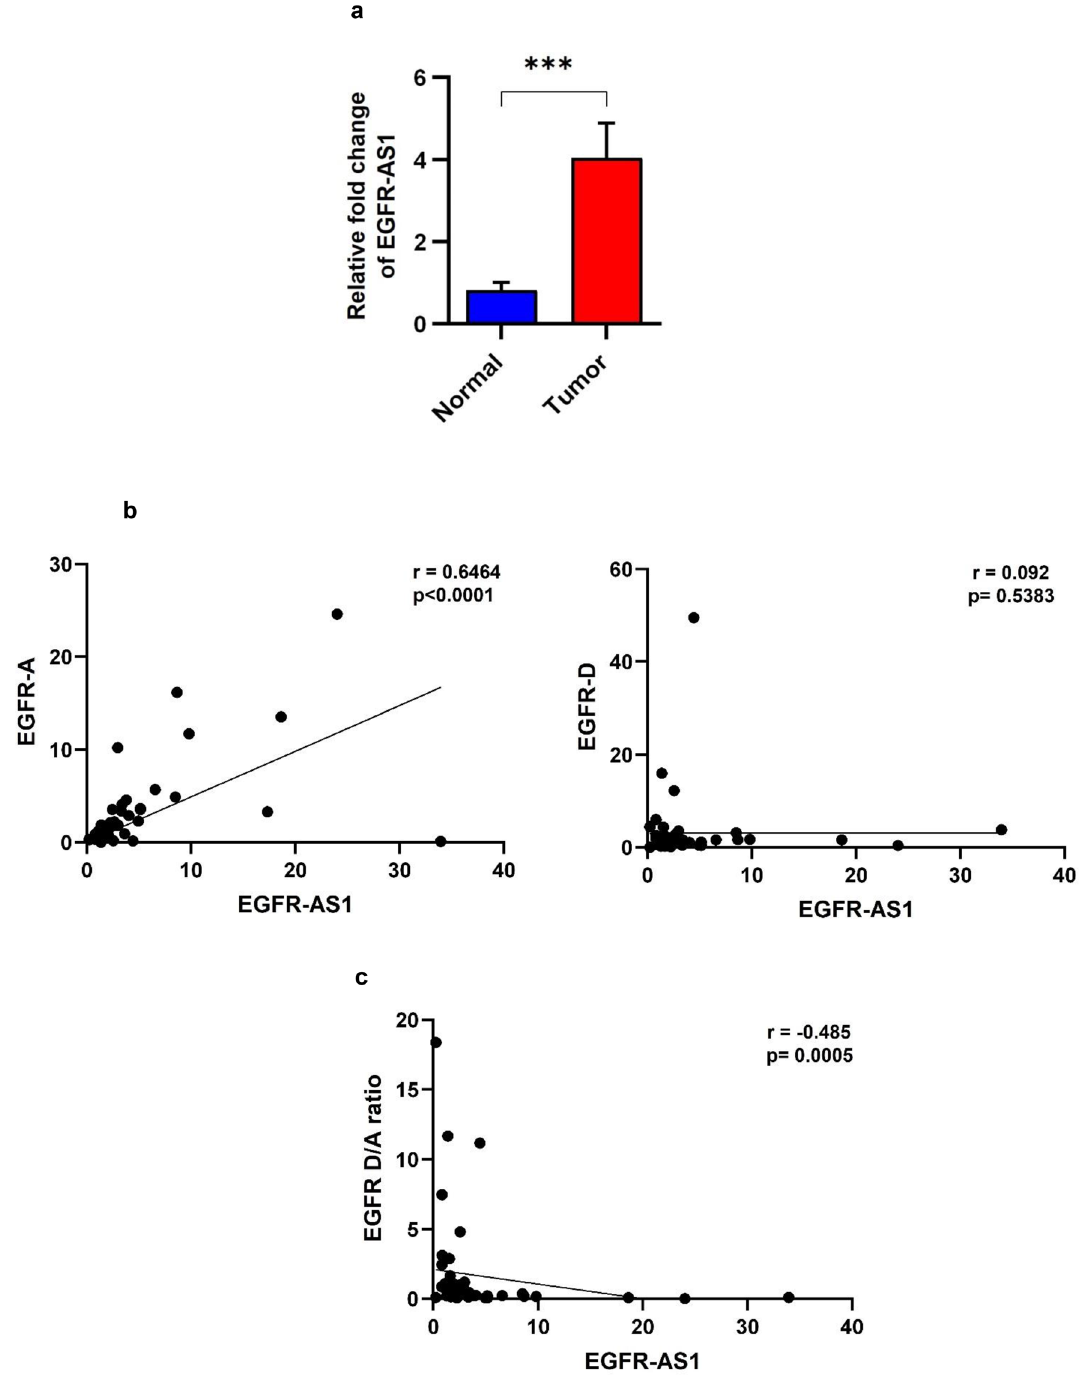
Figure 1. Role of EGFR-AS1 in maintaining the level of EGFR A and D isoforms in OSCC. ( a ) Relative expression level of lncRNA EGFR-AS1 in oral tumors compared with normal tissues. ( b ) Scatter plot showing the correlation analysis of EGFR-A and D isoforms expression in relation to EGFR-AS1 expression. ( c ) Scatter plot showing the EGFR D/A ratio in relation to EGFR-AS1 expression. (Statistical analysis was done by, two tailed Student’s t-test, Spearman rank correlation analysis, p-value *** for <